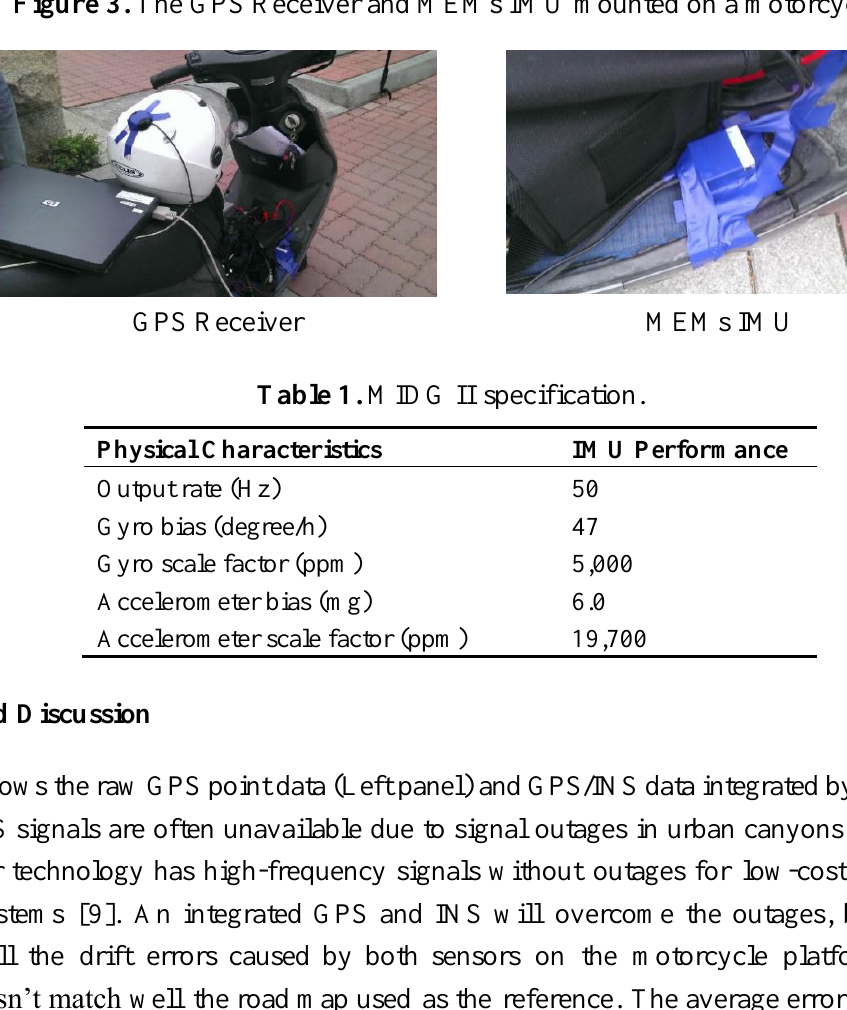
Figure 3. The GPS Receiver and MEMs IMU mounted on a motorcycle.